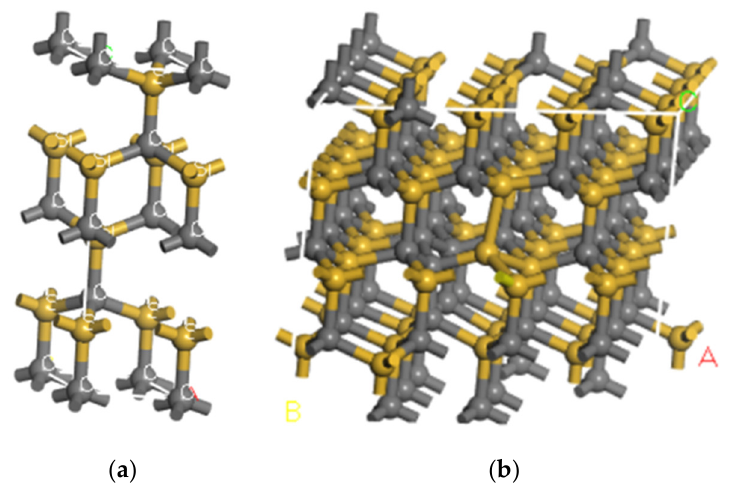
Figure 3. ( a ) Single cell of 4H-SiC; ( b ) 4H-SiC cell is expanded to 4 × 4 × 1 cells. (A, B and C mean the magnification times along the corresponding direction).